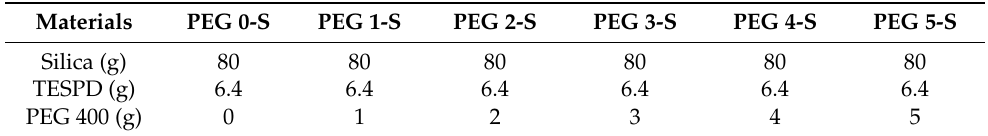
Table 1. Formulation for the modified silica.